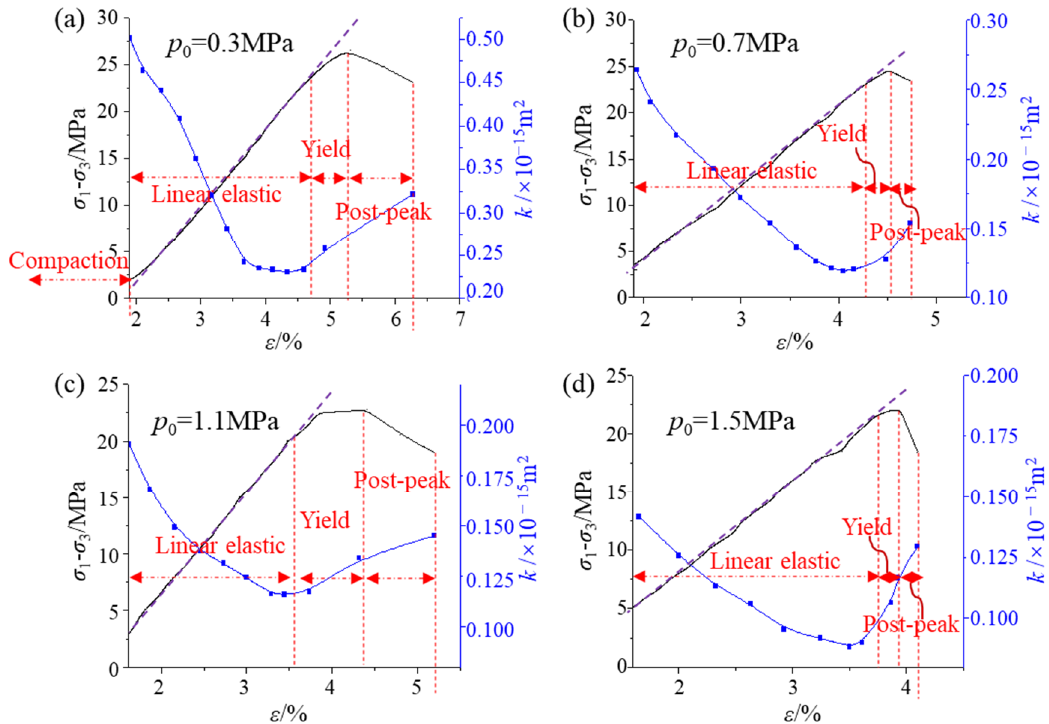
Figure 6. Deviatoric stress–strain and permeability evolution of coal under different gas pressures; ( a ) 0.3 MPa; ( b ) 0.7 MPa; ( c ) 1.1 MPa and ( d ) 1.5 MPa.